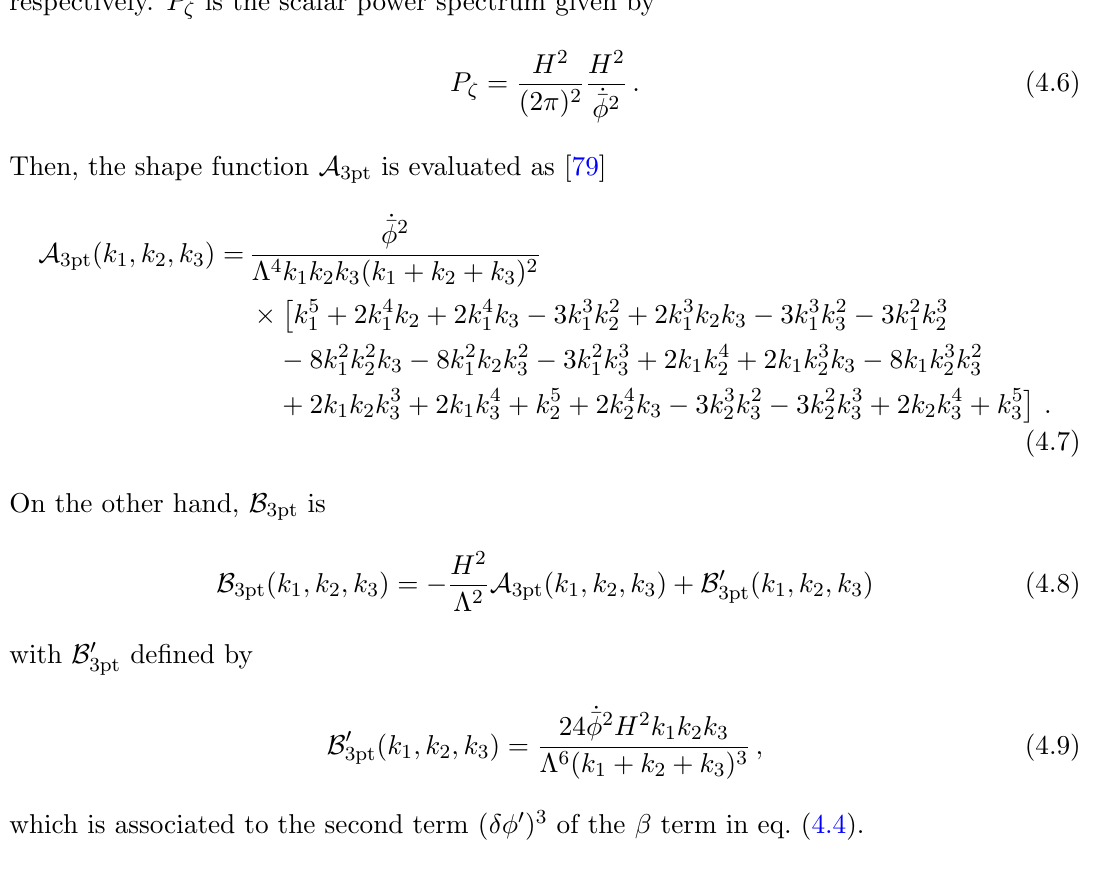
= k = k , but the height at the folded con(cid:12)guration k 1 2 3